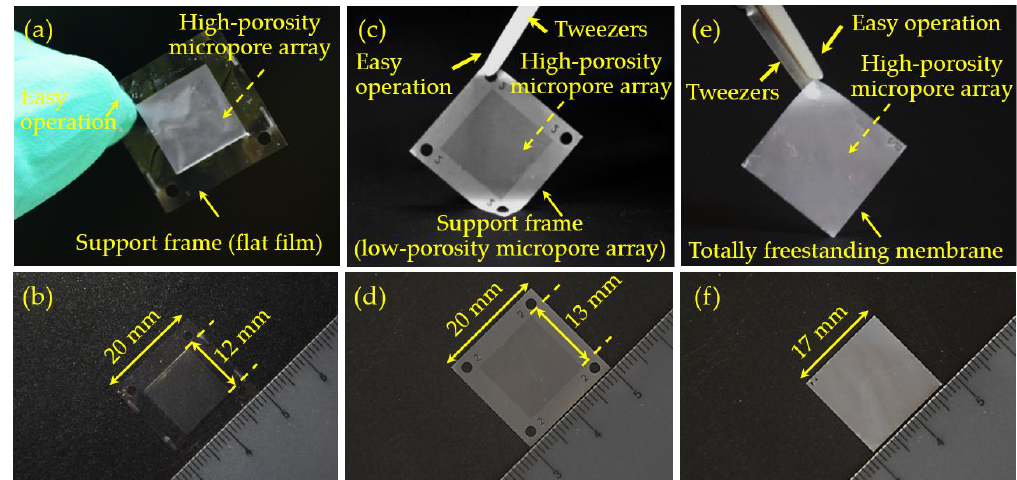
Figure 6. Fabrication results of the Parylene C molding process with a silicon template. ( a ) Si micropillars prepared via photolithography micropatterning and DRIE; ( b ) the prepared Parylene-C micropore array. The scale bars are 10 μm.